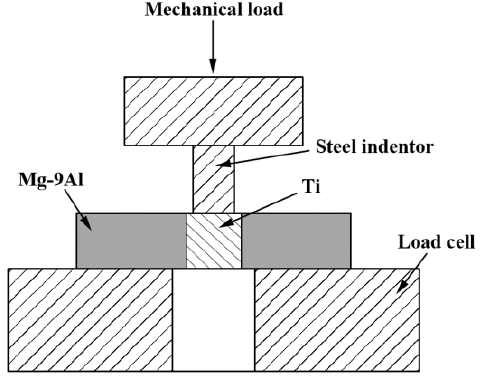
Figure 2. A schematic diagram of the push-out tests.